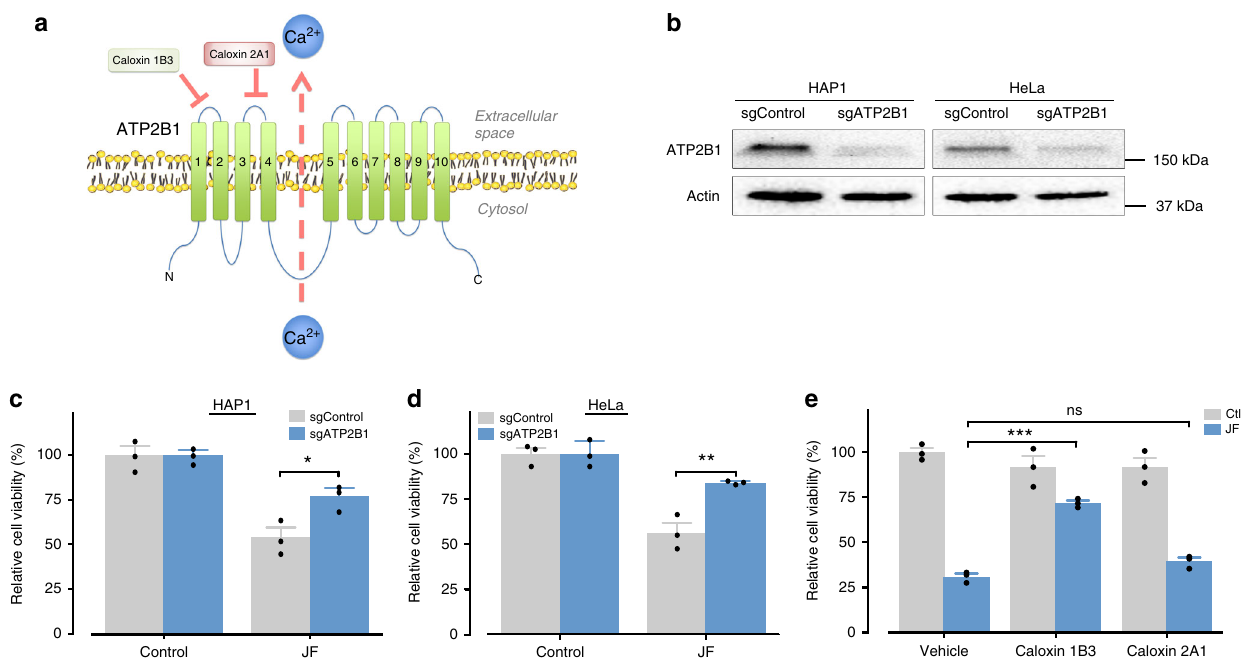
Fig. 3 ATP2B1 is involved in jelly fi sh venom killing. a Schematic representation of ATP2B1. b Western blot validation of sgRNA-mediated depletion of ATP2B1 in HAP1 and HeLa cells. c , d Depletion of ATP2B1 conferring resistance to jelly fi sh venom in c HAP1 (0.75 µ g/ml) and d HeLa cells (1 µ g/ml). e Pre-treatment of caloxin 1B3 but not caloxin 2A1 reduces the jelly fi sh venom-induced cell death. All data represented as mean ± S.E.M ( n = 3). c , d Student ’ s t -test or e one-way ANOVA followed by Tukey ’ s post hoc test, * p < 0.05; ** p < 0.01; *** p < 0.001; ns, not signi fi